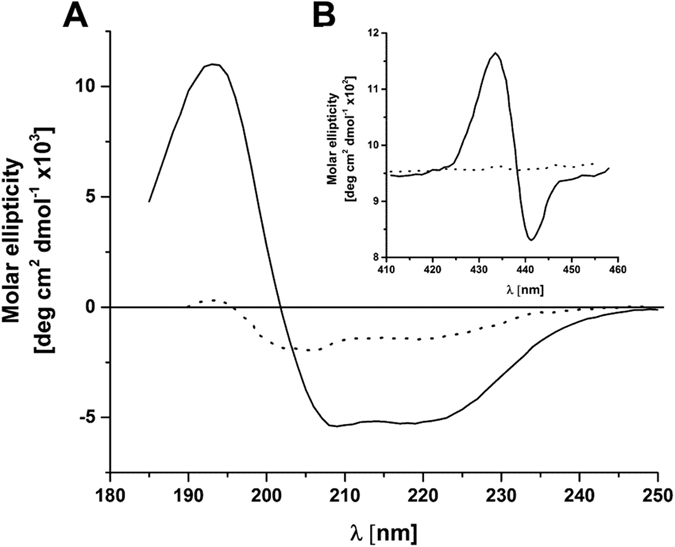
Circular dichroism spectroscopy of native cytochrome b6.(A) Native cytochrome b6 (solid line), denatured native cytochrome (dot line), Spectra are shown for the protein in buffer containing DDM. (B) The description is the same as in panel A.